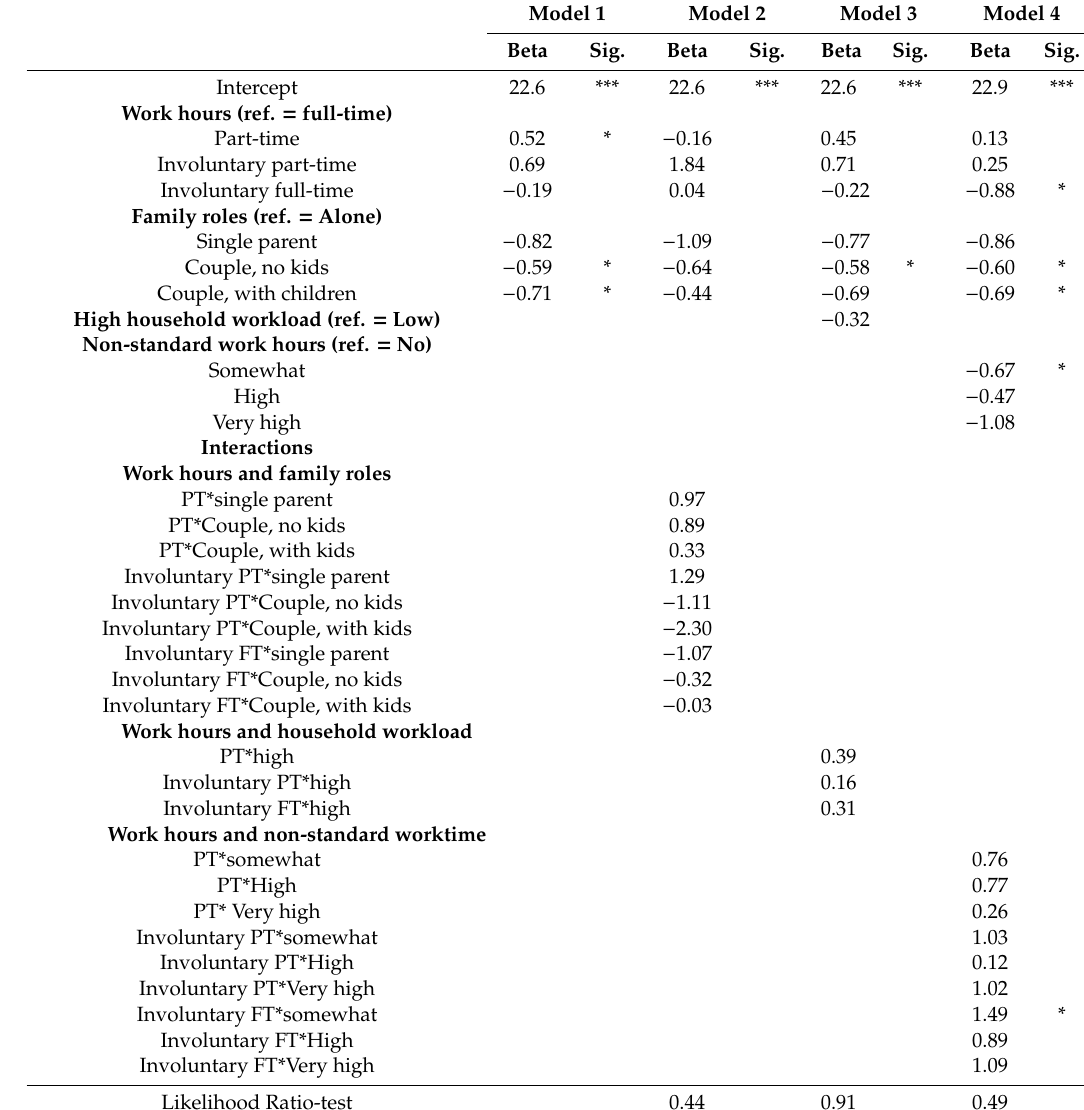
Table 4. Random e ff ect models for di ff erence in MCS scores in 9552 observations for women (population in salaried employment, 20–60 years old, GSOEP wave 21–27. Models controlled for baseline MCS, year, age, income, occupational class, and physical